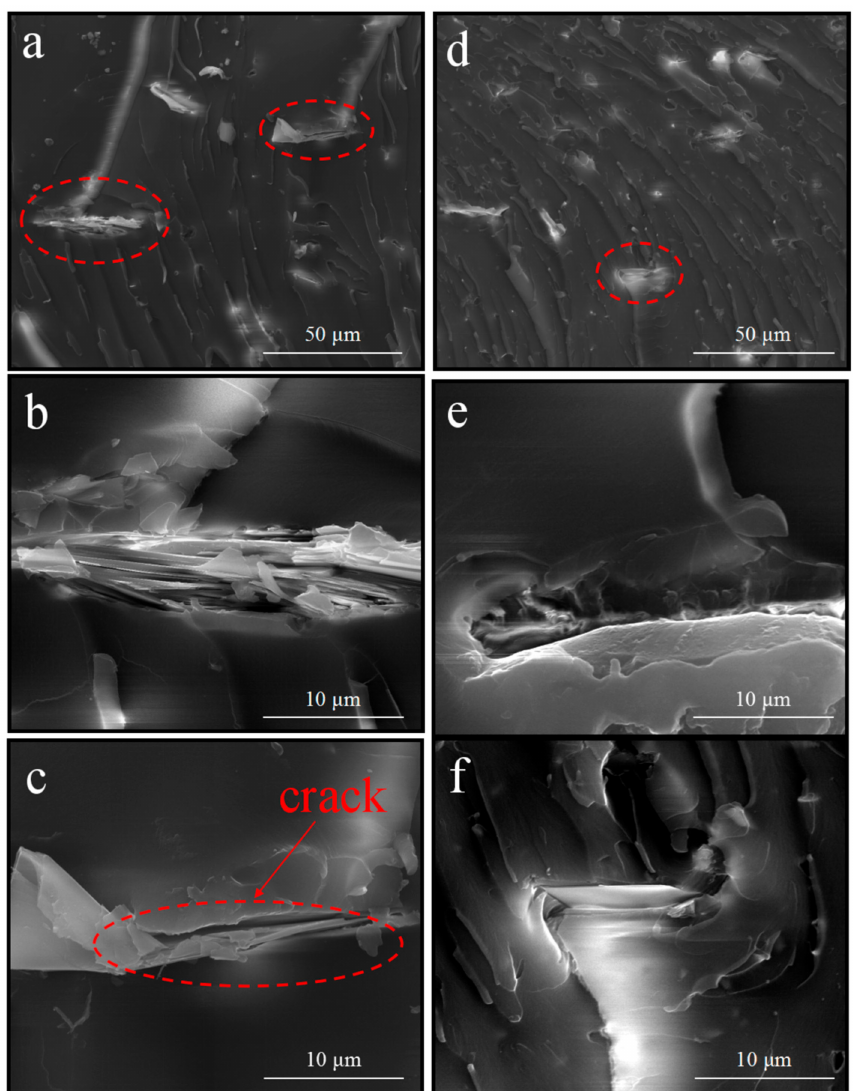
Figure 12. SEM images of the cross-section of ( a – c ) the unmodified mica coating and ( d – f ) the modified mica